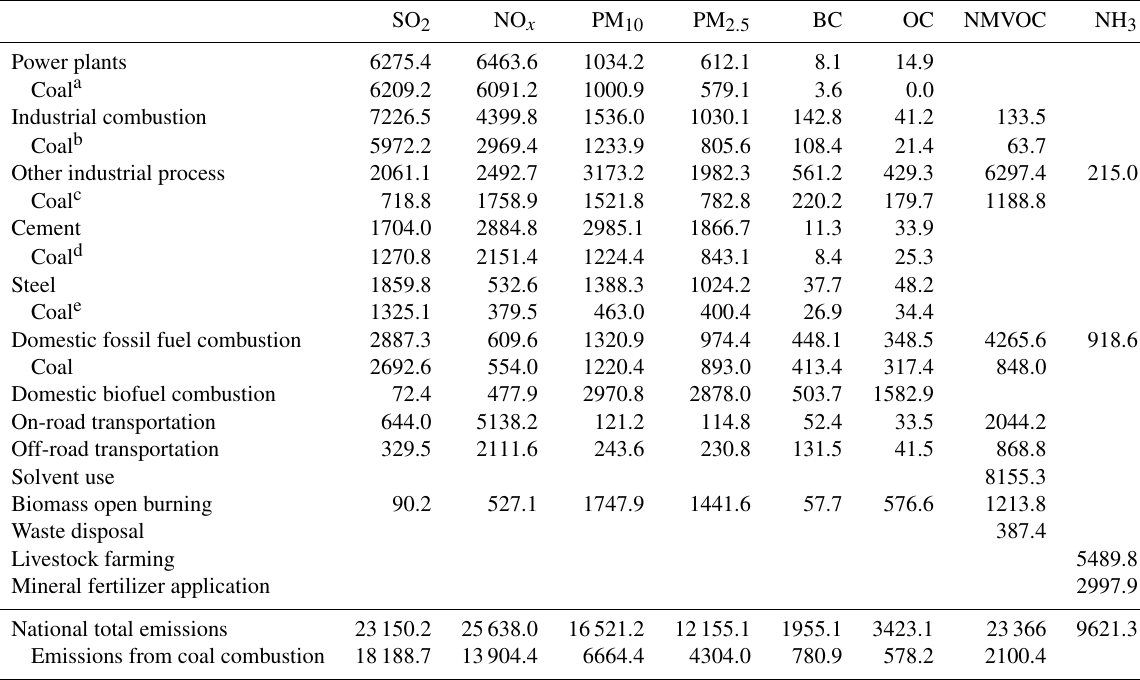
Table 1. Emissions by sector in 2013 in China (unit: kiloton).